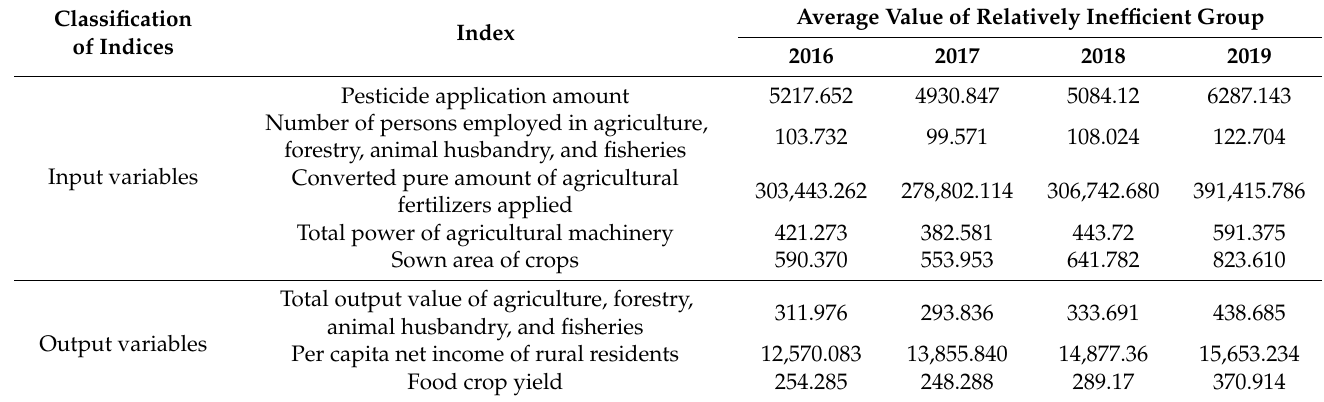
Table 6. Average values of the input–output indices of relatively DEA-inefficient cities